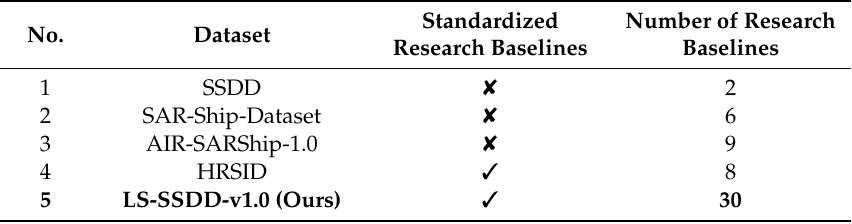
Table 8. Research baselines comparison with other existing